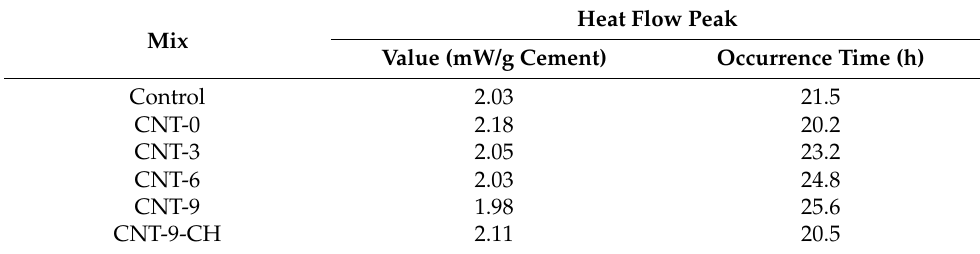
Figure 3. SEM images of the CNT: before H 2 SO 4 /HNO 3 exposure [×70,000 ( a ); ×20,000 ( b )]; after H 2 SO 4 /HNO 3 exposure [×80,000 ( c ); ×22,000 ( d )]. Table 2. Summary of the isothermal